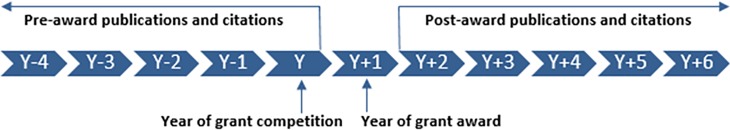
Schematic illustration of the time frames used for the extraction of data on publications and citations.Y indicates the year of the grant competition, and Y+1 the year of the grant award. Pre-award publications were extracted for 5 years, including the year of the grant competition. The post-award period was considered as the 5 years after Y+1, where the publications related to the grant could be expected. The same periods were used to collect the citations of the extracted publications.